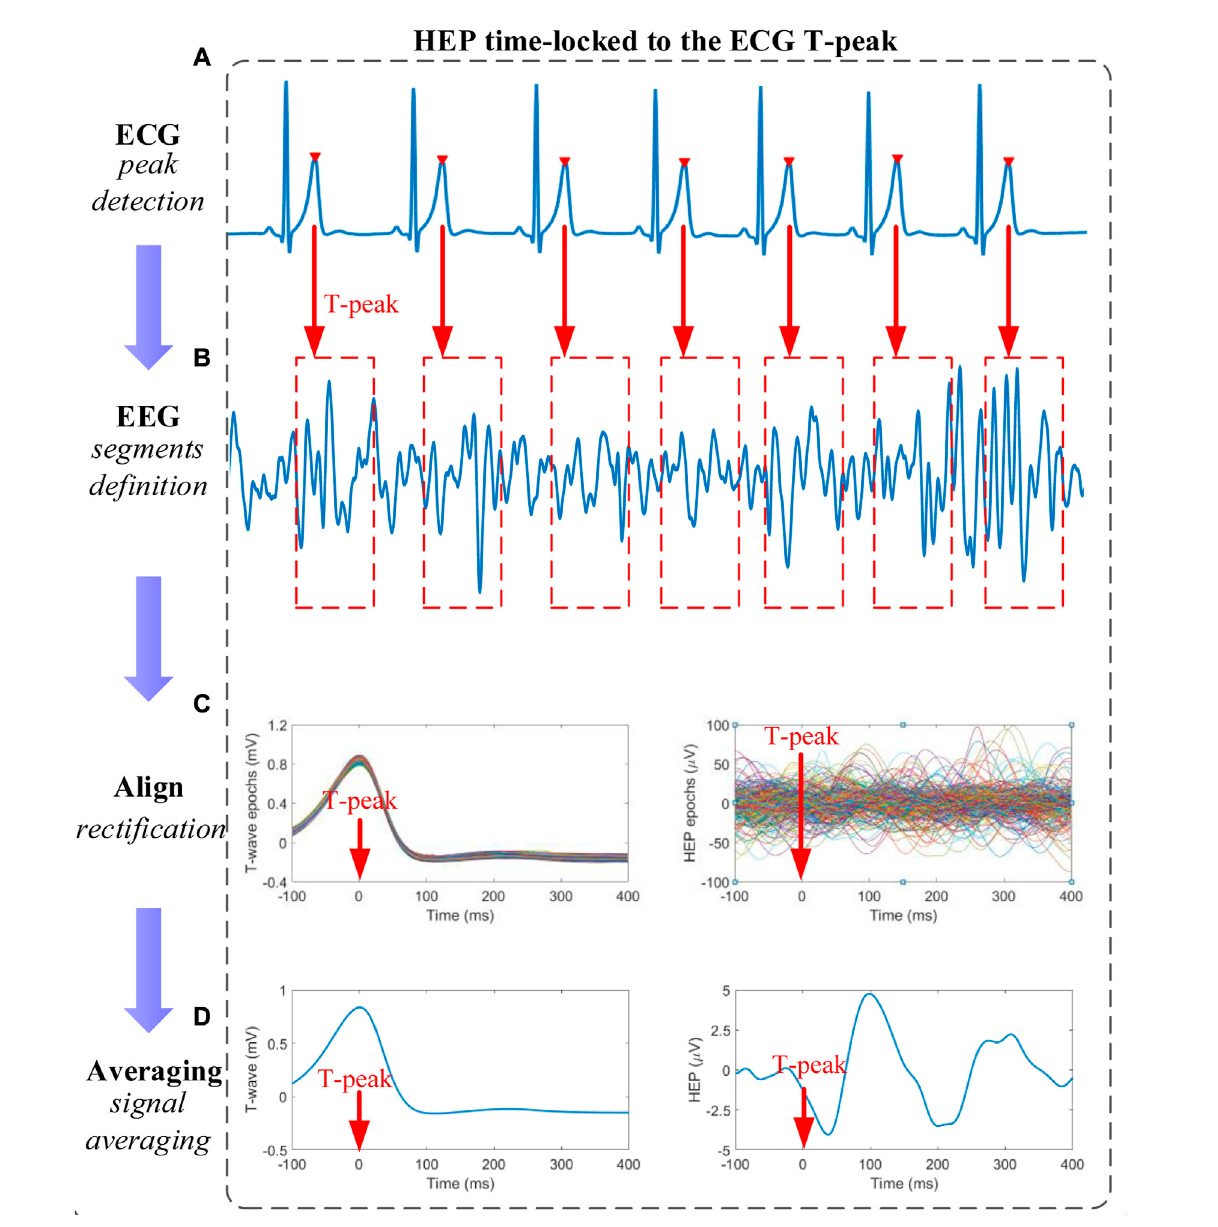
FIGURE 2 Schematic representation of heartbeat evoked potential (HEP) analysis (A) T-peaks detection of electrocardiography (ECG) signals (B) De fi nition of time-lockedT-peakselectroencephalography(EEG)segmentswithacertainlength (C) AllEEGsegmentswerealignedrelativetotheT-peakinsegments after baseline correction and outliers-exclusion (D) The HEP curve is obtained by averaging the signals within the aligned